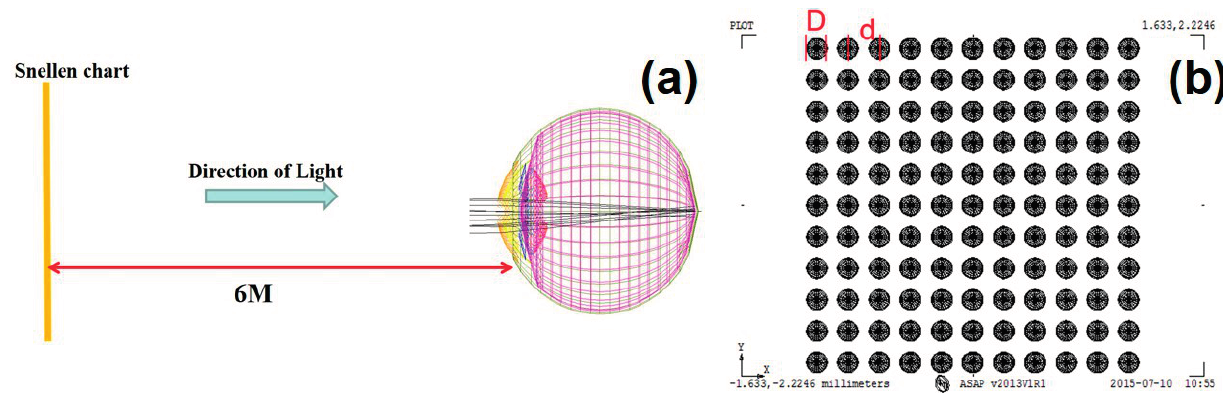
Figure 1. ( a ) Research framework chart; ( b ) schematic diagram of the microstructure placed on the anterior surface of